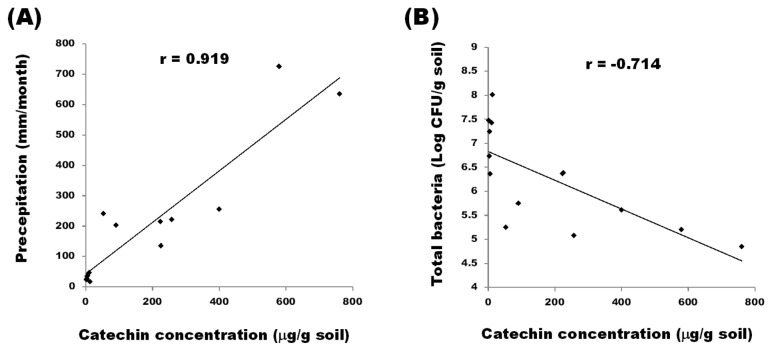
Pairwise correlations between (-)-catechin concentration, monthly precipitation, and bacterial populations.(A) Correlation between the concentration of (-)-catechin in soil of R. formosanum and monthly precipitation (r = 0.919, P < 0.0001, n = 14). (B) Correlation between the concentration of (-)-catechin and bacterial populations in soil of R. formosanum (r = -0.714, P = 0.0041, n = 14).